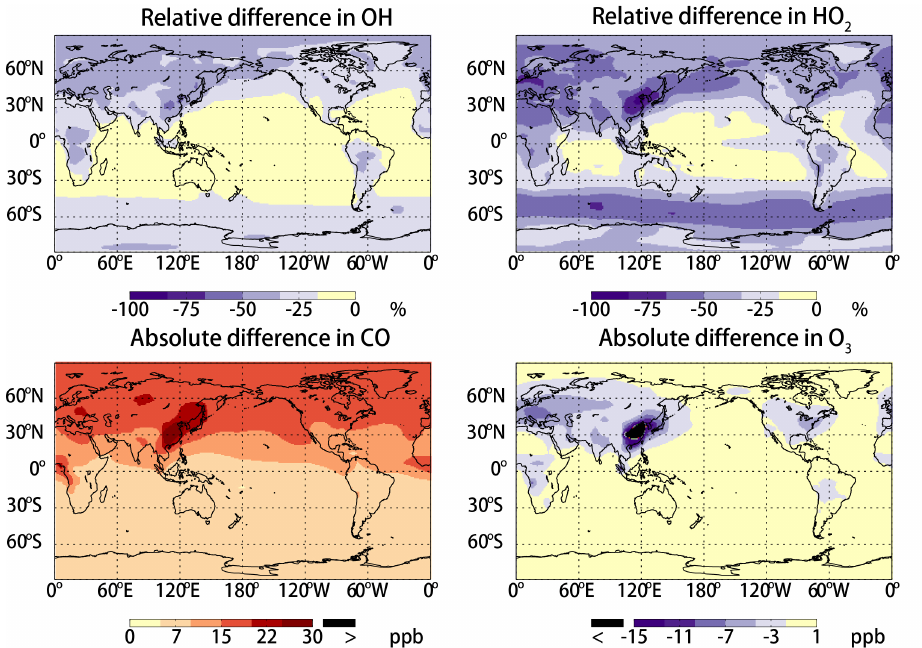
Fig. 4. Effect of HO 2 reactive uptake on non-cloud aerosols ( γ (HO 2 ) = 1 producing H 2 O) on surface air concentrations of OH, HO 2 , CO, and O 3 in the GEOS-Chem model. Values are annual means for 2005 and are calculated by difference with a simulation including no HO 2